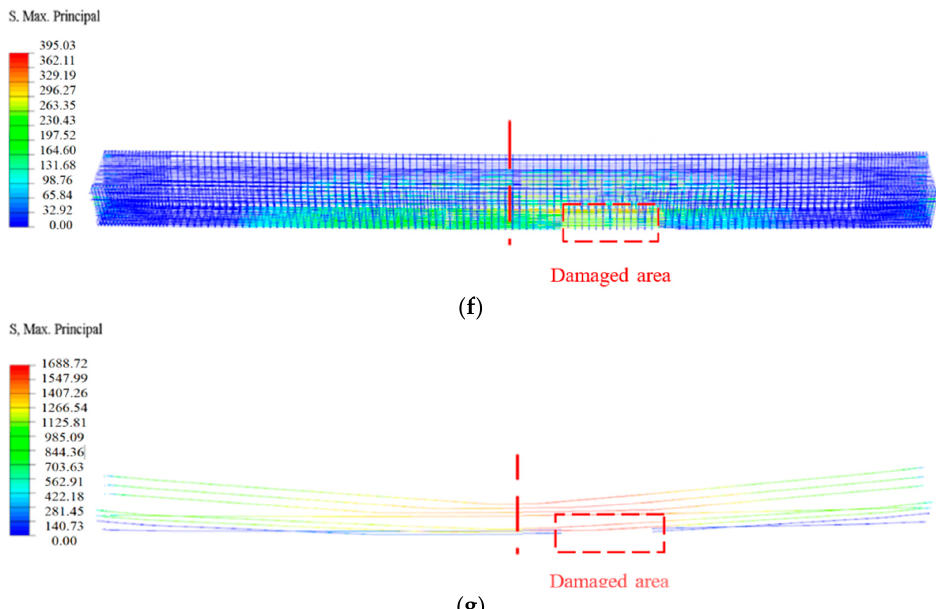
Figure 15. Stress diagrams of the steel bars, steel plates and pretensioned strands. ( a ) The steel bars of the undamaged #3-2 girder; ( b ) The pretensioned strands of the undamaged #3-2 girder; ( c ) The steel bars of the repaired #3-2 girder strengthened by steel plates; ( d ) The steel plates of the repaired #3-2 girder strengthened by steel plates; ( e ) The pretensioned strands of the repaired #3-2 girder strengthened by steel plates; ( f ) The steel bars of the damaged #3-2 girder; ( g ) The pretensioned strands of the damaged #3-2 girder.